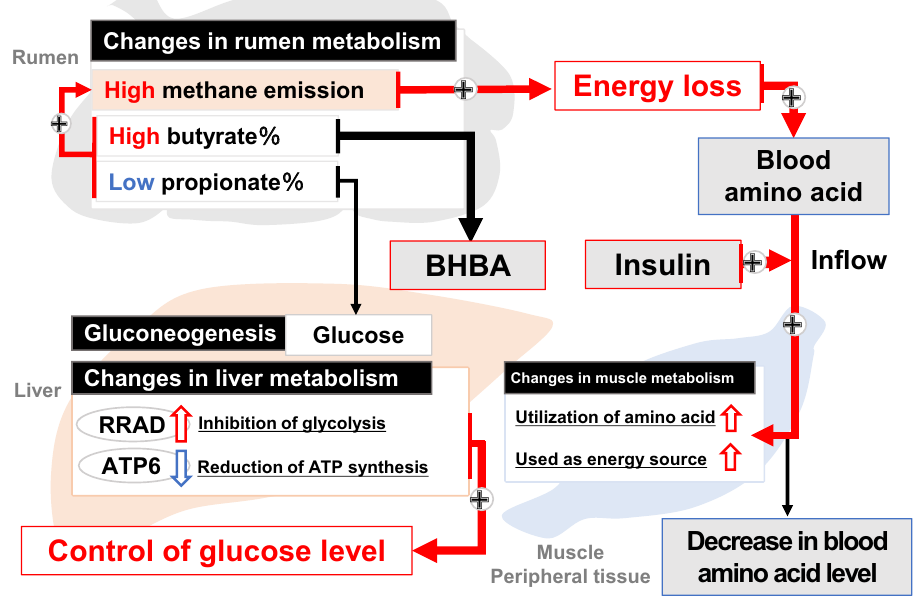
Figure 5. Proposed model for physiological parameters and hepatic transcriptomes related with high methane emission in Japanese Black cattle. The cattle with high methane emission seems to actively utilize the amino acid to replenish for the loss of energy used in methane production, resulting in a decrease in blood amino acid levels and an increase in blood insulin concentration with no changes of growth and